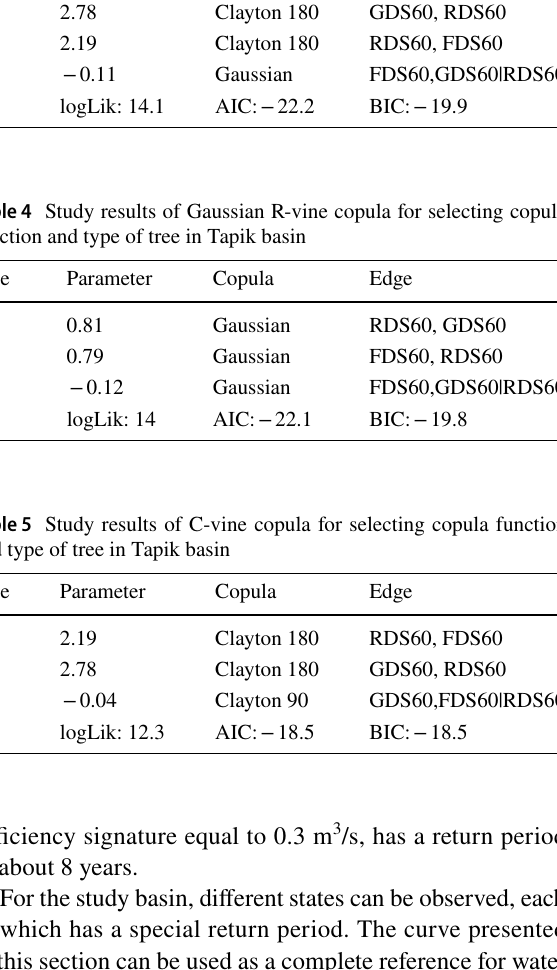
Fig. 8 Study of correlation of studied signatures using Kendall’s tau in Tapik basin Table 3 Study results of R-vine copula for selecting copula function and the type of tree in Tapik basin Tree